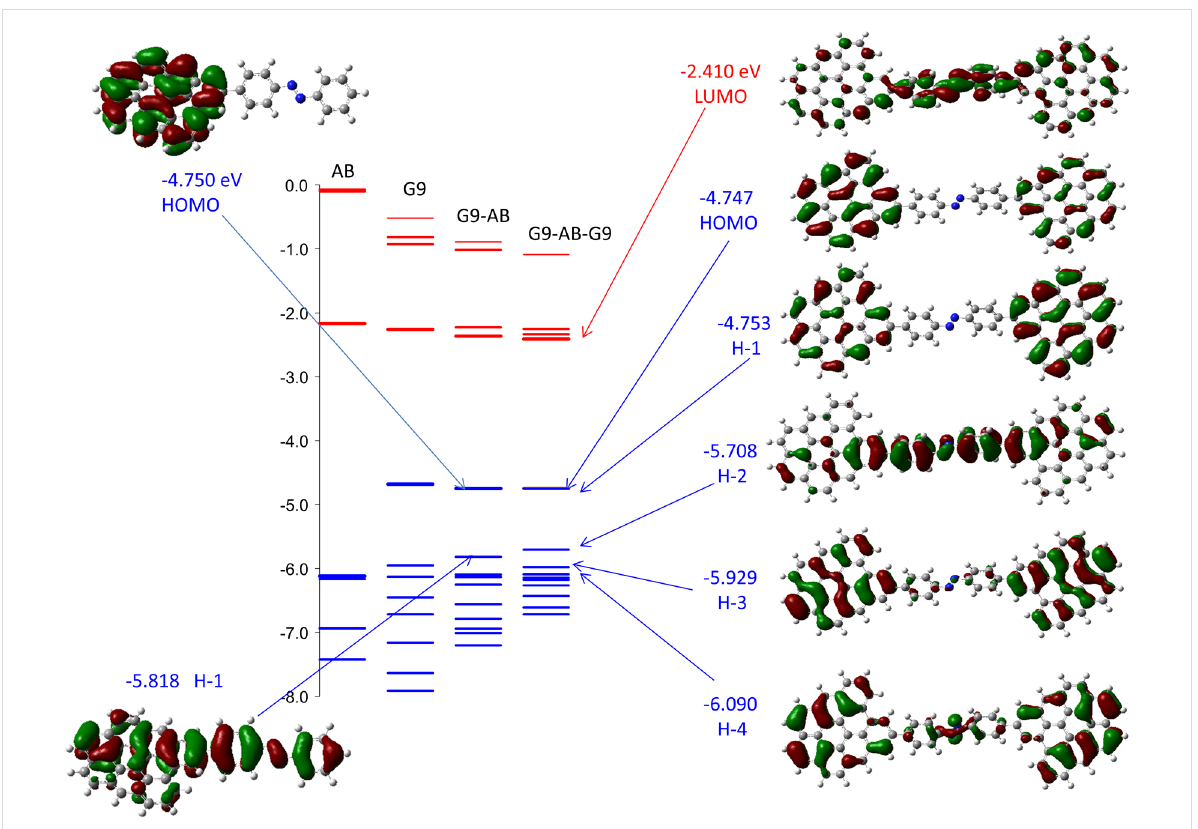
Figure 4: Orbitals for G9–AB–G9 added to the orbital energy diagram of Figure 2. All structures are presented in their optimized geometry, with dihe- dral angles between AB and G9 of 36 and 39°.